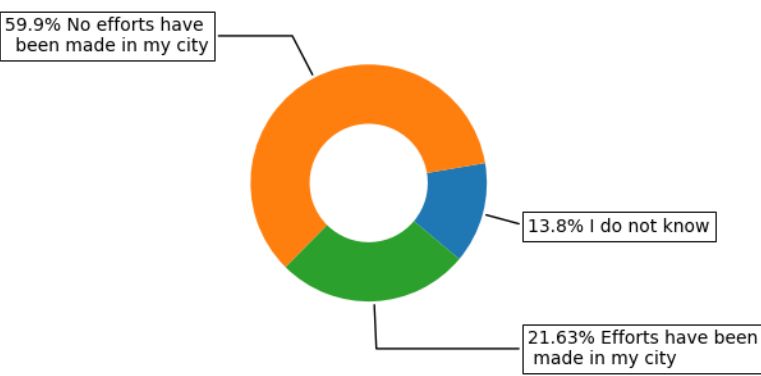
Figure 3. Efforts to transform your city to a smart city.